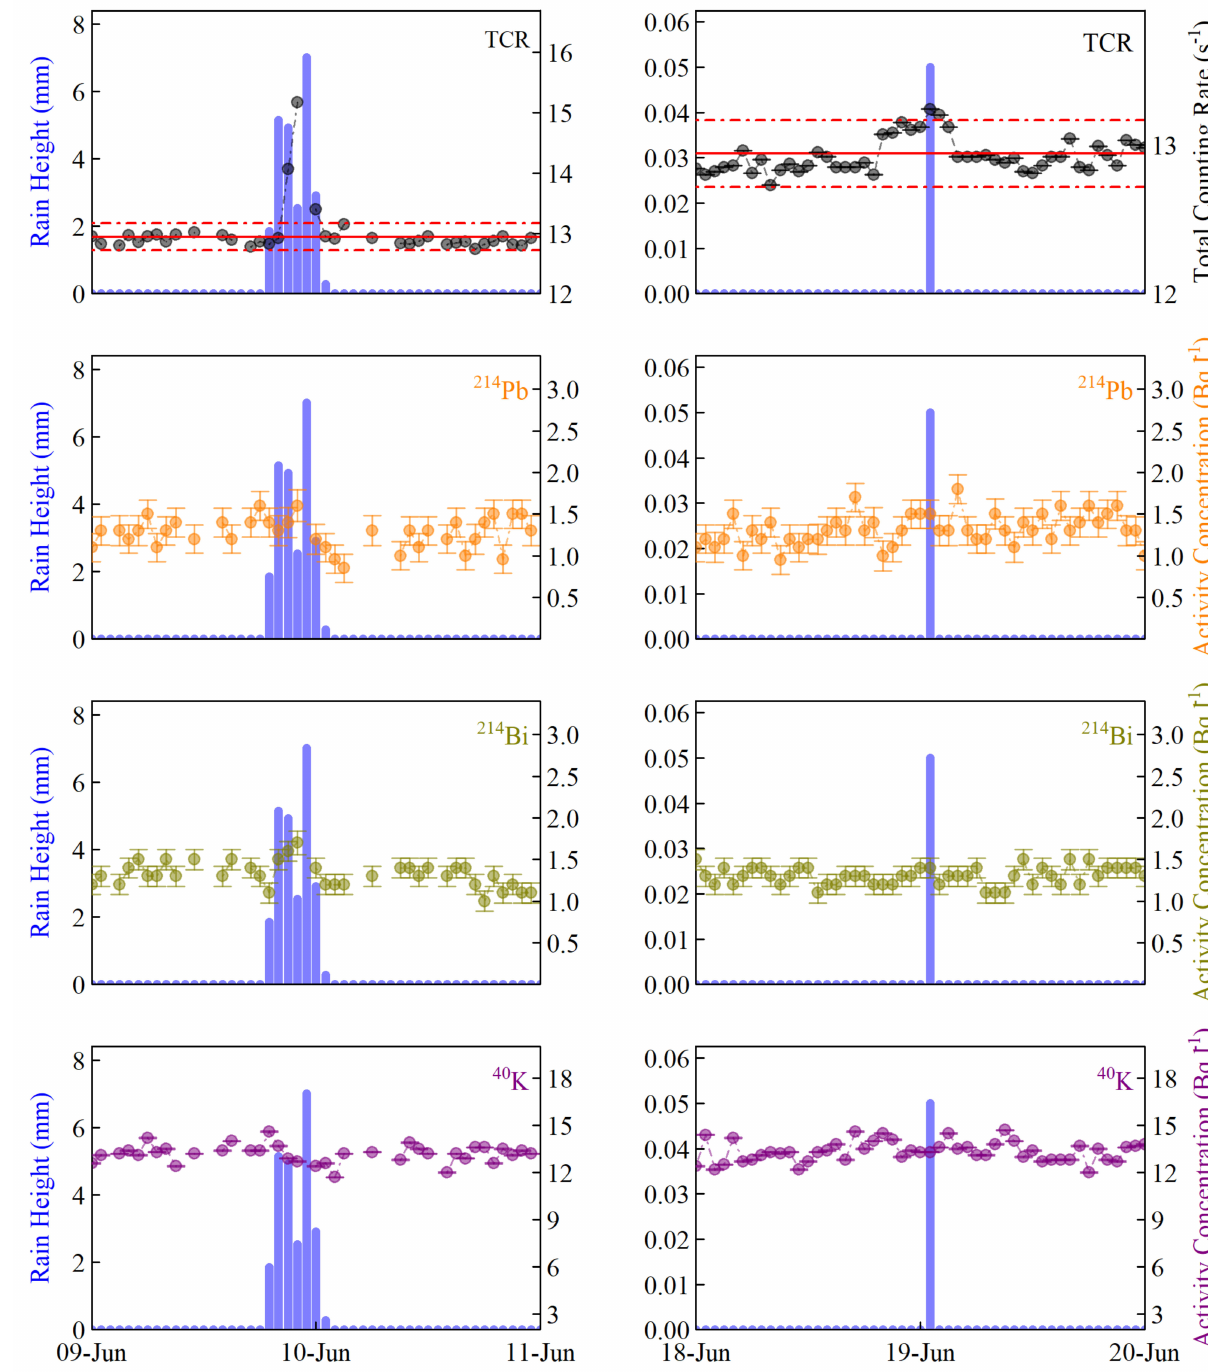
Figure A2. Representative rainfall events of June 2016. The y -axis of the first column regards rain height values (blue bars) while of the second TCR values, 214 Pb, 214 Bi and 40 K activity concentration (circular points). In the subplots of TCR, the mean value during dry meteorological periods is depicted as a red solid line, and the range of the statistically significant criterion is depicted with red dotted